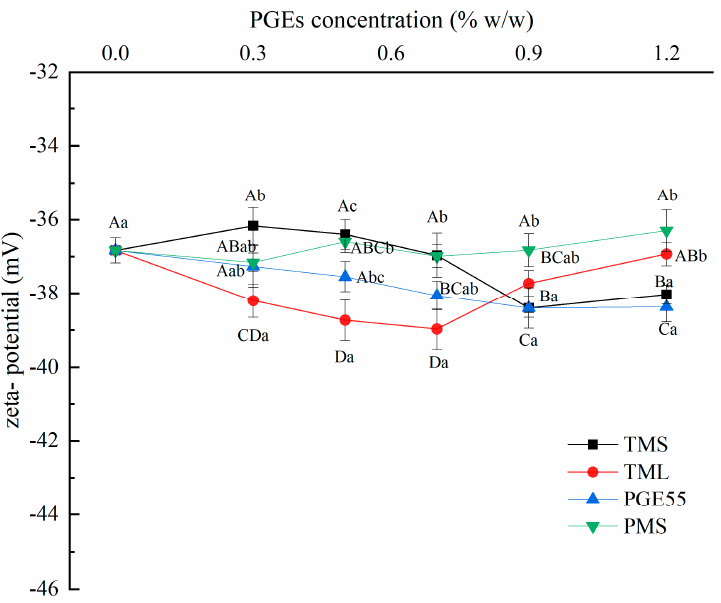
Figure 3. Effect of different PGEs on zeta potential of RDC emulsions. Uppercase letters indicate differences between concentrations, and lowercase letters indicate differences between PGEs.